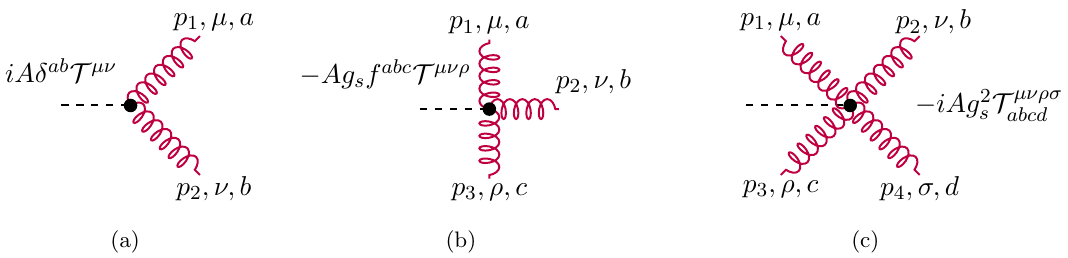
Figure 19 . Feynman rules for Hgg , Hggg , and Hgggg couplings in the m t momenta are taken to be ingoing.